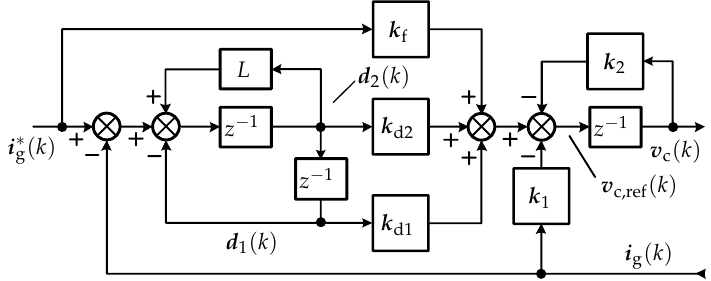
Figure 4. Structure of the reference-tracking controller C 1 ( z )